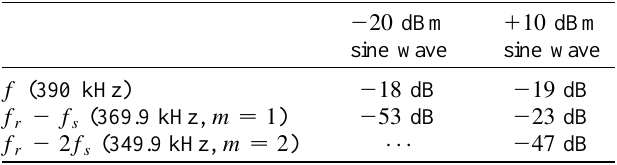
TABLE III. The beam spectra amplitude measured by the spec- trum analyzer when modulating the rf voltage at a frequency of 369.9 kHz.